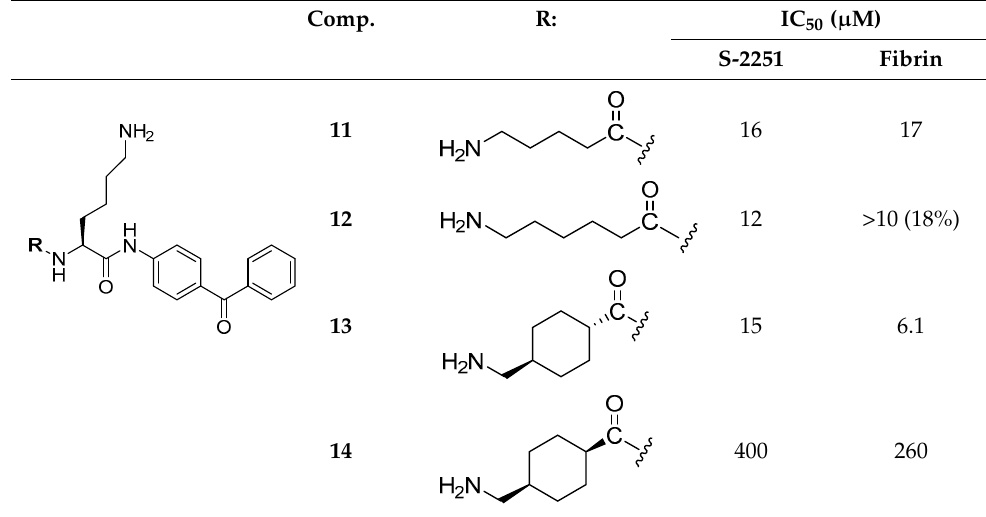
Table 3. Plm inhibitory activity of compounds 11–14 [29] .